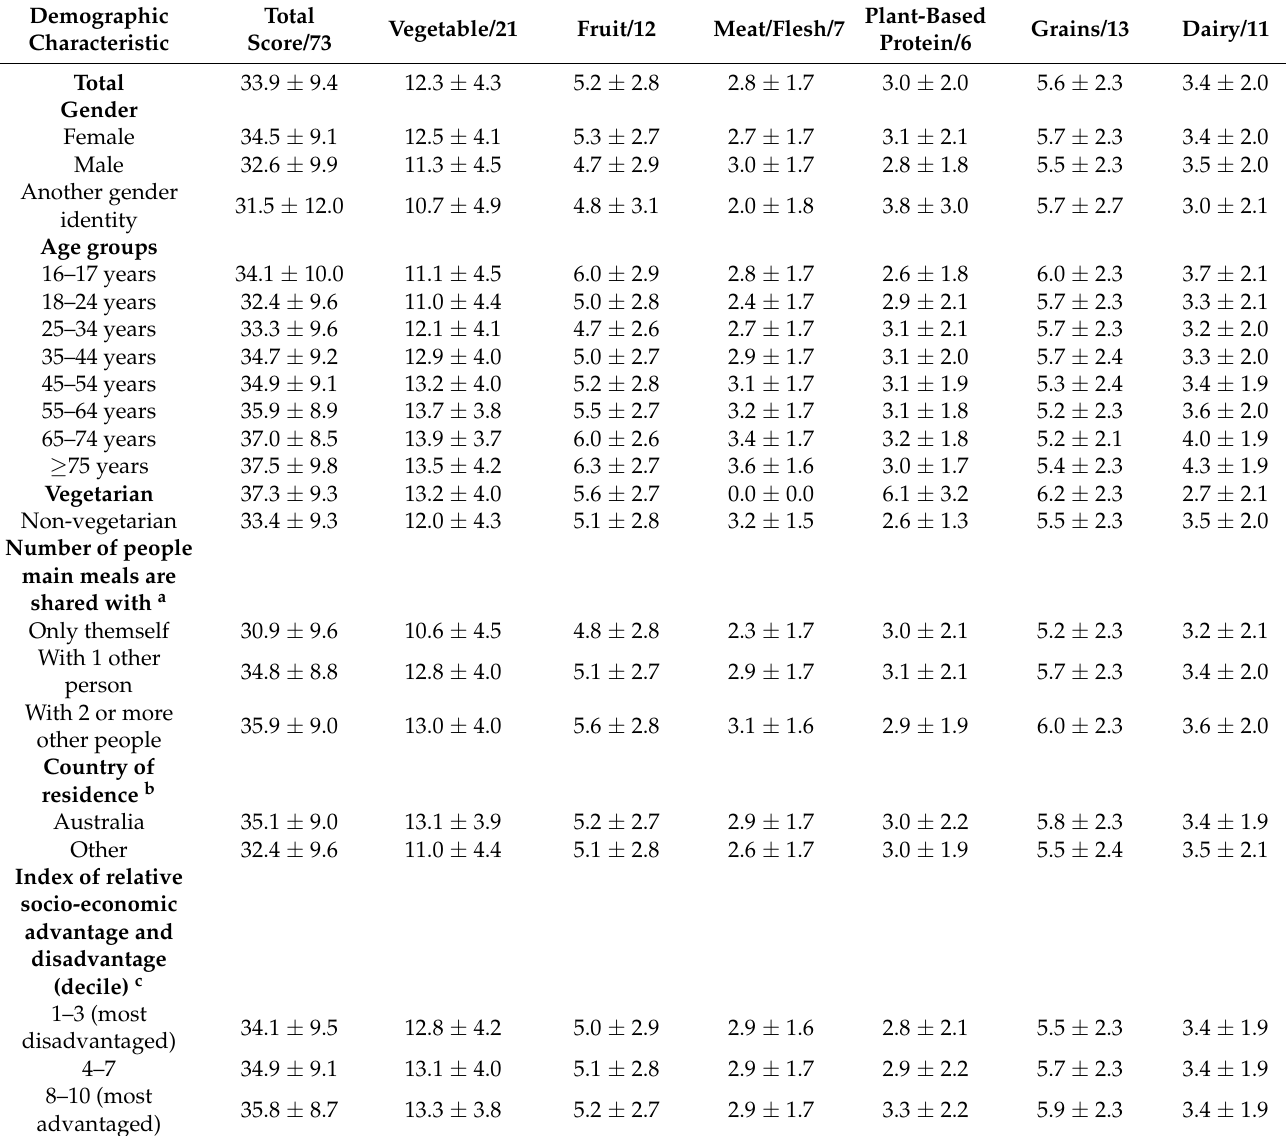
Table 2. Healthy Eating Quiz total and sub-scale scores by demographic characteristics ( n = 176,075).